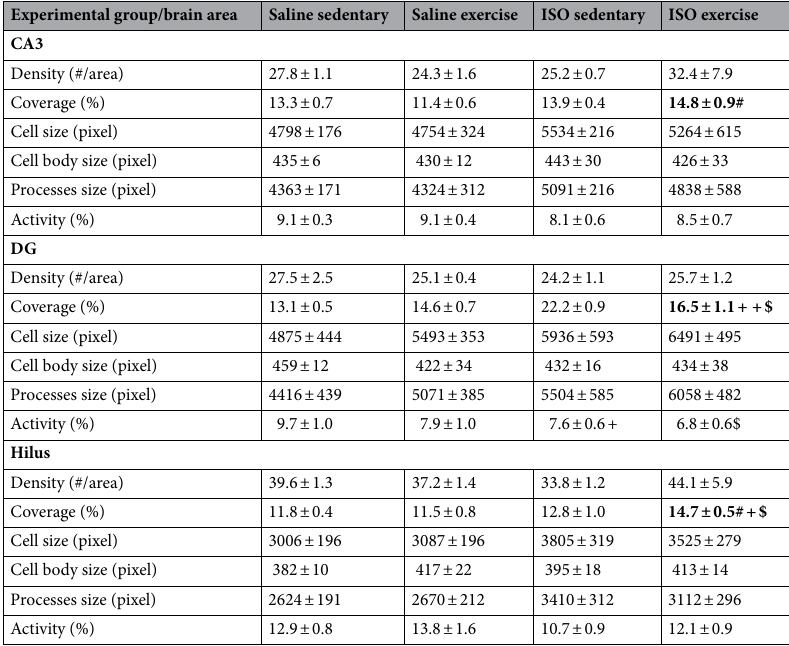
Table 1. Morphological parameters of microglia in different areas of the hippocampus CA3, Dentate Gyrus (DG) and Hilus), in saline or isoproterenol (ISO) treated rats, under sedentary conditions or after five weeks of exercise training (n = 4, 4, 6, 6 for saline sedentary, saline exercise, ISO sedentary and ISO exercise rats, respectively). *Significant effect of ISO compared to respective saline groups ( p < 0.05); #: significant effect of exercise training compared to respective sedentary groups ( p < 0.05); $: significant effect of combined ISO and exercise, compared to saline sedentary ( p < 0.05); + : potentially relevant effect 0.05 < p < 0.1. Significant values are in bold.